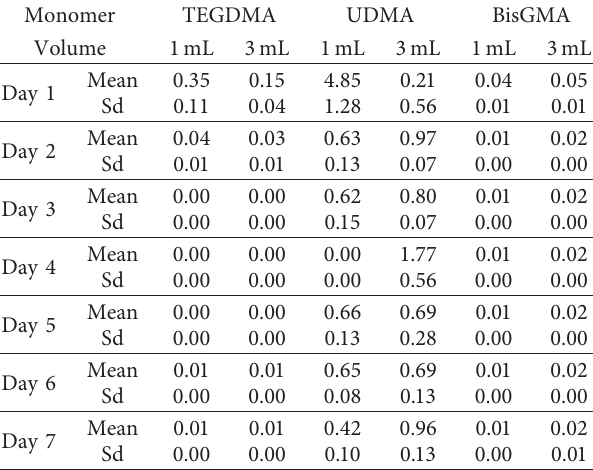
Table 5: Daily release of monomers from BG ( µ g). Monomer